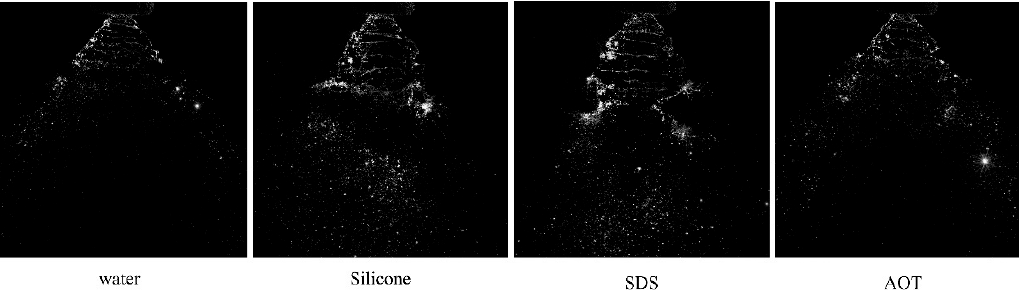
Figure 6. Spray images of TXVK nozzle with water, silicone, SDS, and